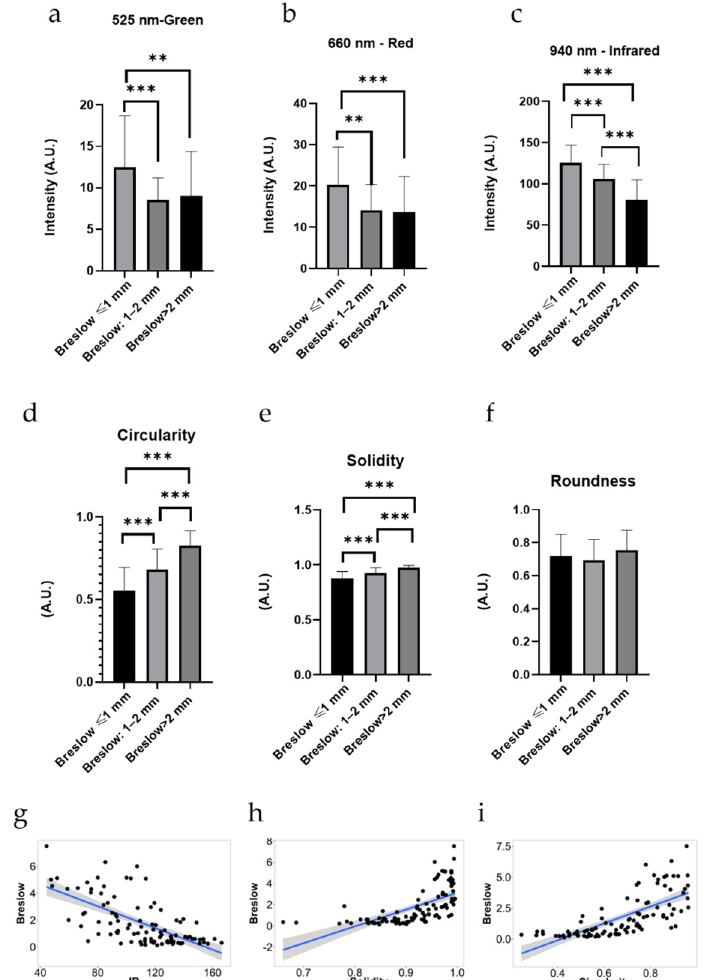
Figure 2. Comparison of melanomas with different tumor thicknesses and correlations between intensity values, shape descriptors, and Breslow thickness. One-way ANOVA and Tukey’s post comparison test were used to compare the intensity values and shape descriptors. The intensity values proved to be statistically significant ( a ) G ( p < 0.0001), ( b ) R ( p < 0.0001), and ( c ) IR ( p < 0.0001) and among the shape descriptors. ( d ) Circularity ( p < 0.0001) and ( e ) solidity ( p < 0.0001) were statistically significant. The roundness ( f ) could not separate the three groups effectively ( p : 0.2759). Moreover, the (G ( a ), R ( b ), and IR ( c ) channels proved to be effective to identify tumors of Breslow ≤ 1 mm from the other two groups, whereas the IR channel could differentiate the Breslow 1–2 mm and Breslow >2 mm from each other. Pearson’s correlation was used to correlate Breslow thickness with IR, circularity, and solidity. It showed a high correlation between IR intensity ( g ) and Breslow tumor thickness (r: − 0.659, 95% confidence interval: − 0.7576 to − 0.5317, p : <0.0001), whereas the correlations between Breslow tumor thickness and G or R intensities were low (r: − 0.226 and − 0.244, respectively). The correlation was high between solidity and Breslow thickness ( h ) (r: 0.6324 95% confidence interval: 0.4978 to 0.7372, p : <0.0001) and high between circularity and Breslow thickness ( i ) (r: 0.7109, 95% confidence interval: 0.5980 to 0.7961, p : <0.0001) p values between 0.01 and 0.001 were